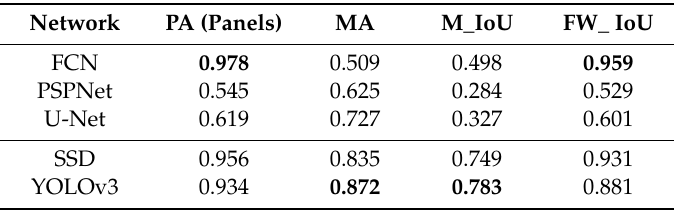
Table 9. Comparative with results published by Dev et al. [21], using the same metrics (best result produced for each metric appears in